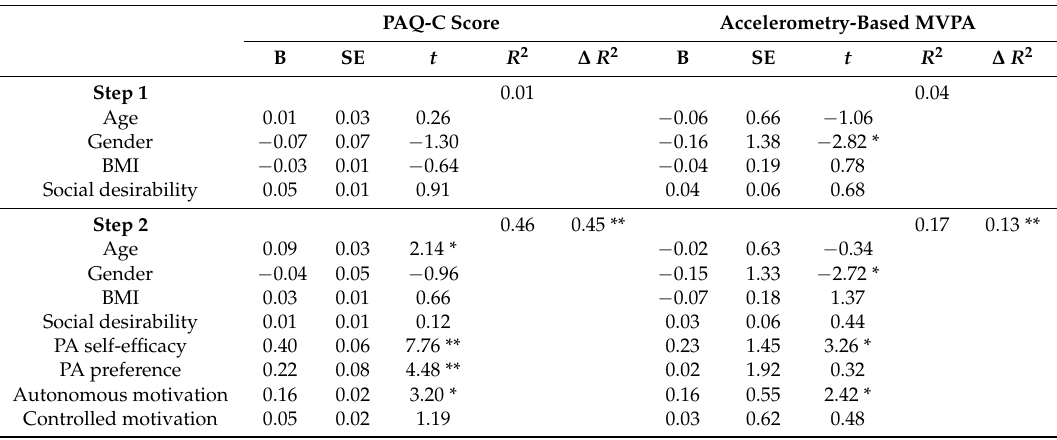
Table 3. Hierarchical Multiple Regression Analyses Predicting the PAQ-C Score and Objectively Monitored MVPA ( n =